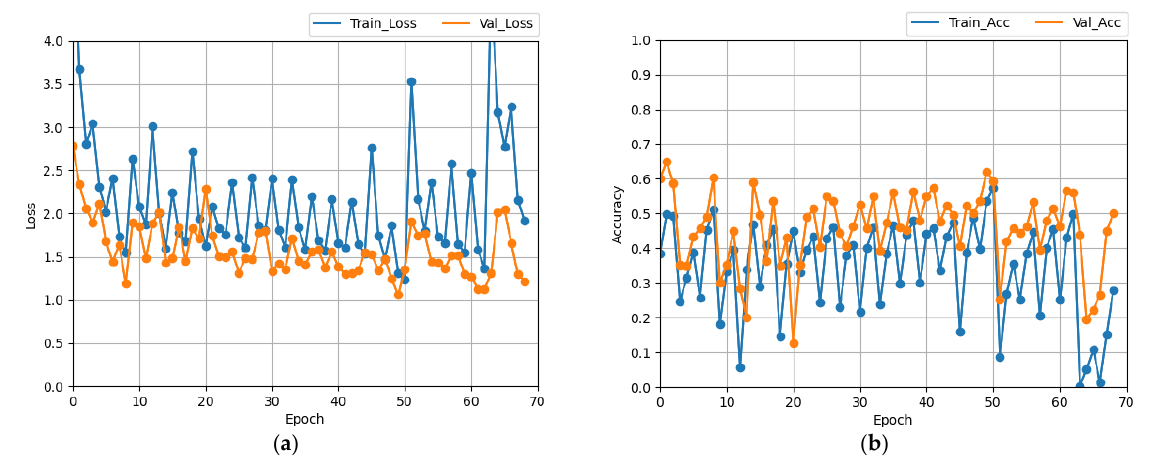
Figure A1. Training result for the state-of-the-art (SOTA) learning method. ( a ) loss; ( b ) accuracy. The triplet loss model was trained using the existing triplet loss learning method with 1000 epochs. Figure A2 illustrates the training results.